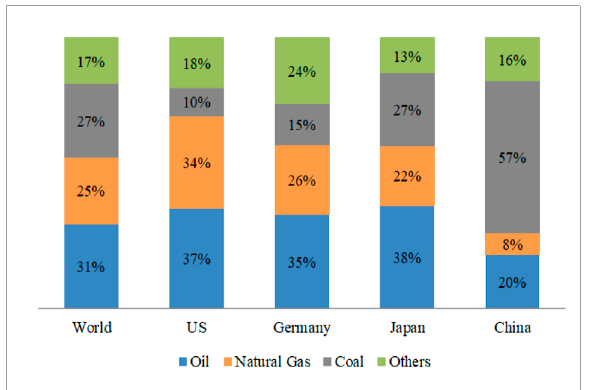
FIGURE 1 Shares of primary energy in different countries. See British Petroleum (2020b), Available at